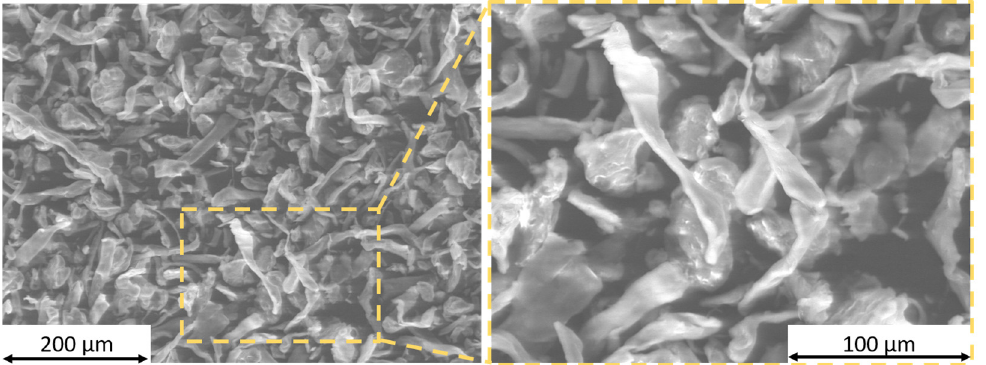
Figure 1. SEM micrographs of the cellulose fi bers. Low magni fi cation on the left (200×) and higher magni fi cation on the right (500×) with the focus on the morphology of the fi bers.